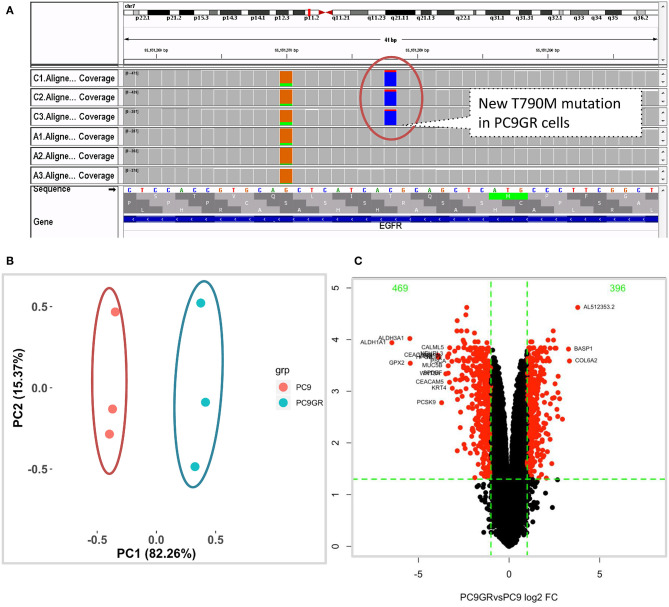
Mutation and gene expression profiles of PC9 and resistant PC9GR cells. (A) IGV view of EGFR gene from RNA-seq sequence reads showing acquired T790M mutation in the PC9GR cells (marked as C1, C2, C3 in the IGV tracks), which is absent in parental PC9 cells (marked as A1, A2, A3). (B) Principal component analysis for PC9 and PC9GR cells. Component 1 accounts for 82% of variance, and resistant cells have quite different expression profiles from PC9 cells. (C) Volcano plot of differential expression analysis between PC9GR and PC9 cells. Red highlights are genes with false discovery rate <0.05 and fold change >2 (either higher or lower in PC9GR cells). The green numbers on the top are the number of down (469) and up (396) regulated genes in PC9GR cells.